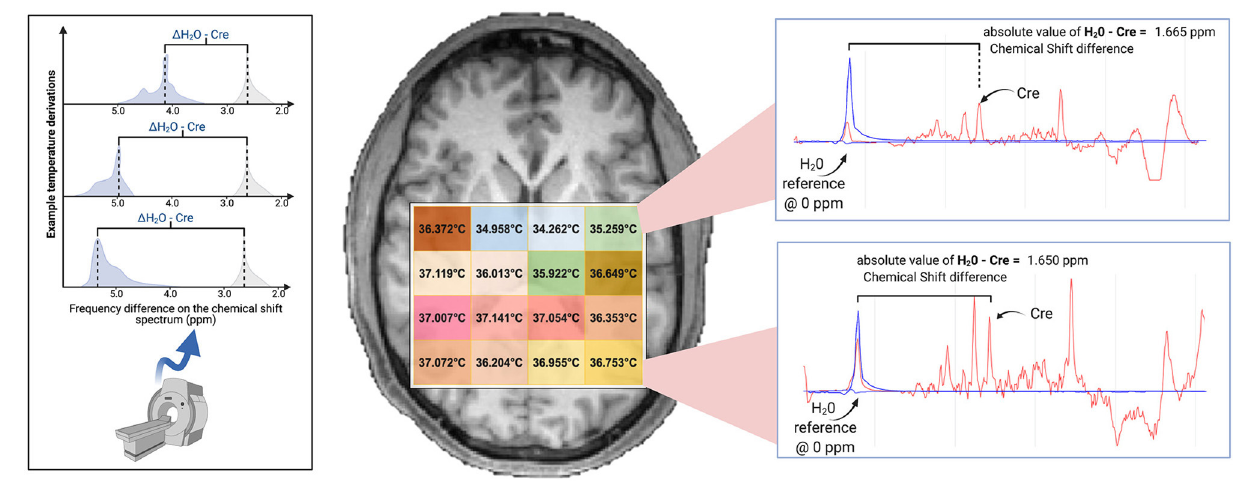
FIGURE 1 | Brain temperature can be non-invasively derived from volumetric magnetic resonance spectroscopic imaging (MRSI) data by calculating the frequency difference between the temperature-sensitive water peak and one or more metabolite peaks that are temperature-insensitive ( left * ). When using creatine as the reference, voxel-level brain temperature can be calculated according to the following equation: T CRE = − 102.61( 1 H20 − CRE ) + 206.1 ◦ C, 1 H20 − CRE = chemical shift difference between the creatine and water resonances. Example T CRE calculations are provided for a participant’s single tissue slice ( right ). Representative spectra illustrate 1 H20 − CRE derivations, with plots depicting a water-suppressed metabolite spectrum ( red line ), with an overlay that indicates the location of the reference water signal ( blue line) . Spectral plots were created within the Metabolite Imaging and Data Analysis System (MIDAS) software package, and the figure was created using BioRender. * Adapted from Dehkharghani et al.